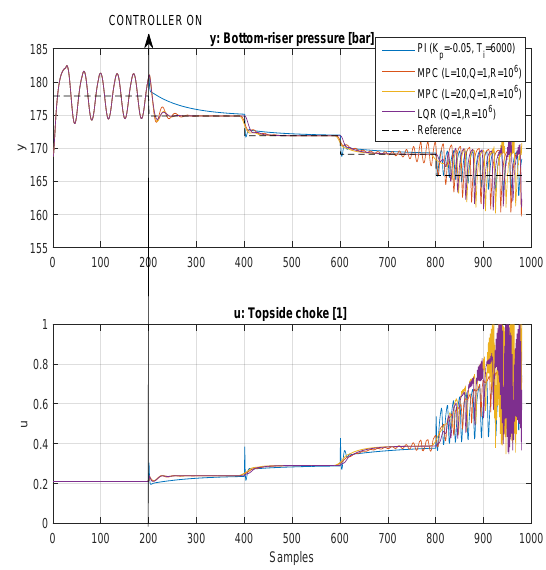
Figure 7: Raw data with length, N = 2000 samples. Identification and validation are chosen with lengths, N id = 1301 and N v = 1800. Sam- pling time, ∆ t = 100 sec. @0.20